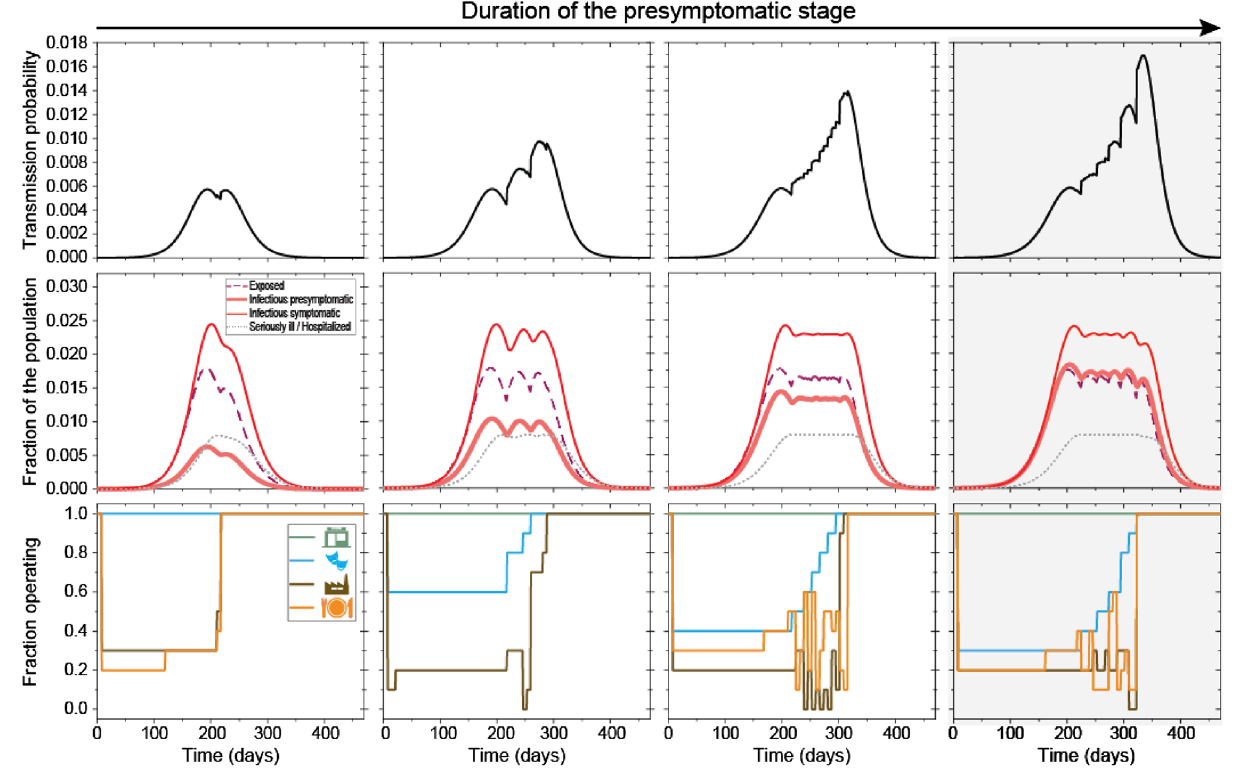
Figure 5. The effect of the duration of the presymptomatic stage on the course of the controlled epidemic. Transmission probability (first row) can be controlled by the selective (partial) closing or opening of certain venues (economic sectors) (last row). With a longer presymptomatic stage (columns, increasing from left to right), the epidemic lasts for a shorter time (middle row), and a higher portion of the economic activities need to be restricted (last row) to avoid the overflowing of the hospital capacities. Patients in the I ps stage infect on average 1.5; 2.5; 3.5 and 4.5 individuals corresponding to t 1 = 1.393 ; 2.3217 ; 3.2504 and 4.1791 days in the columns, respectively (see Supplementary Table 3). Results with shaded backgrounds correspond to the solution of the game, which is also depicted in Fig. 3. Parameters are otherwise as in Fig.